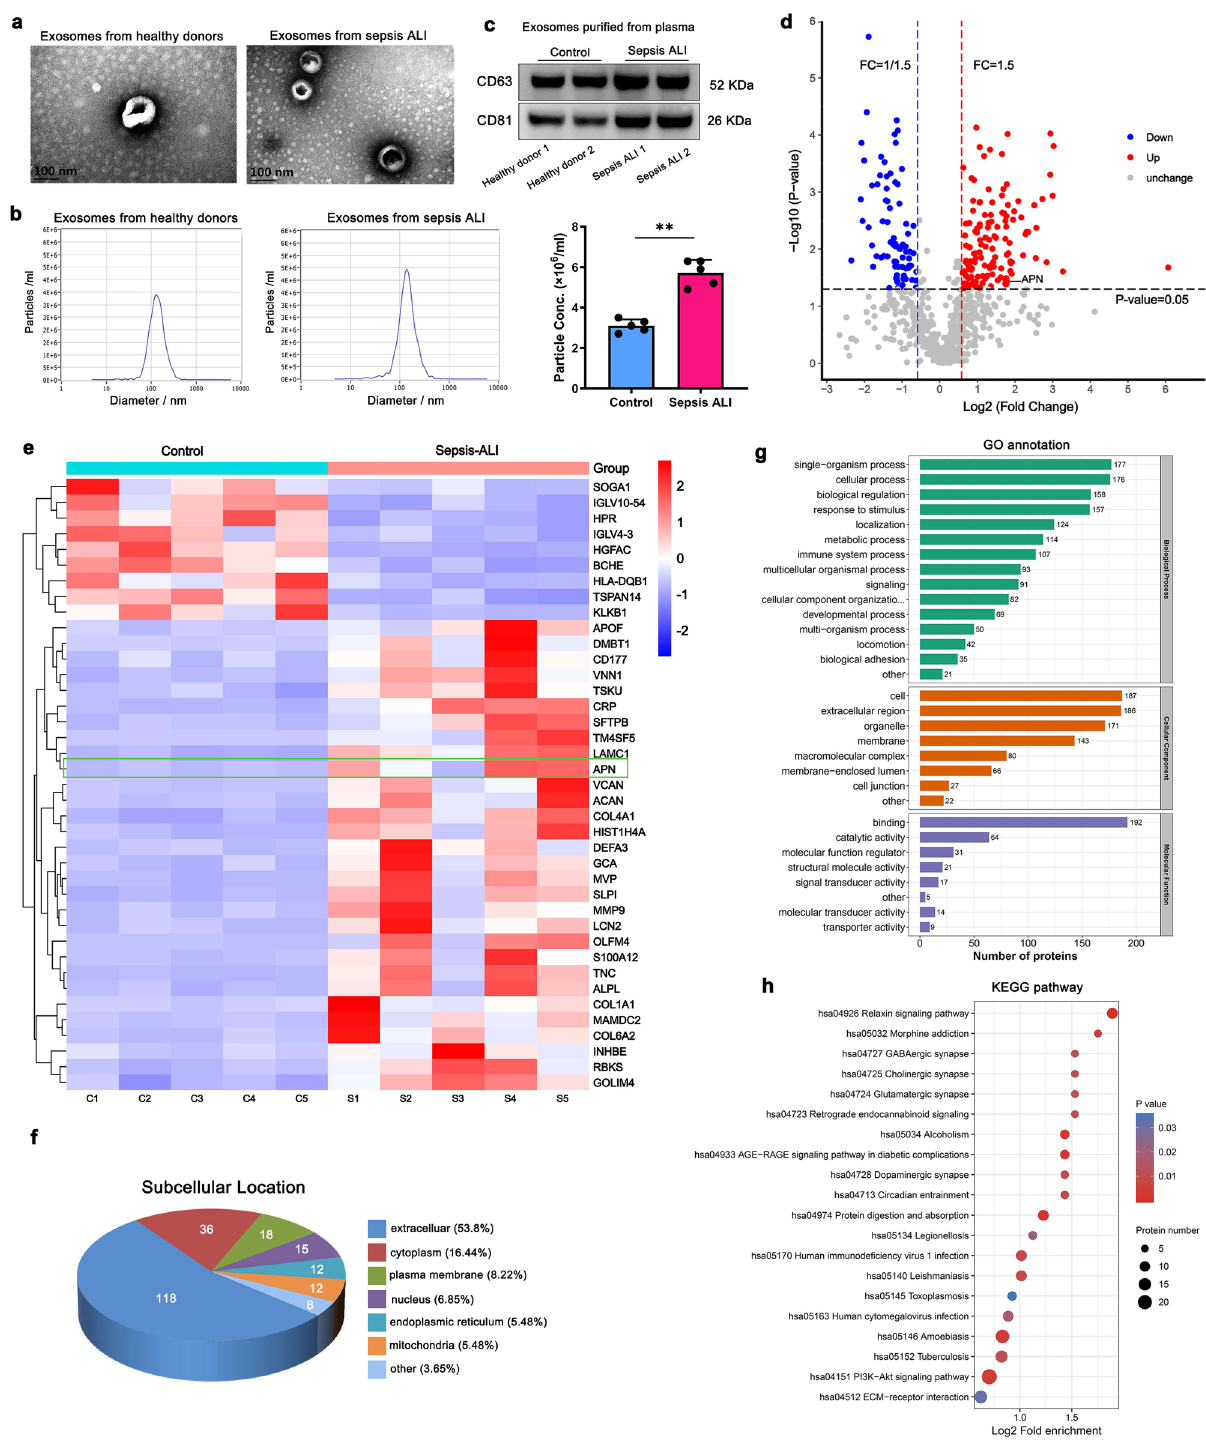
Fig. 1 Proteomics analysis of plasma exosomes from the controls and sepsis-induced ALI patients. a Scanning electron microscopy images of plasma exosomes from healthy donors and patients with ALI caused by sepsis (scale bar: 100 nm). b Concentration (particles/mL) and modal size (nm) of exosome samples according to NTA measures. Mean ± SD ( n = 5), ** P < 0.01. c Exosome markers, including CD63 and CD81, were analyzed using western blot analysis. d Volcano plot showing differentially expressed protein in plasma exosomes from the healthy donors compared to sepsis-induced ALI patients. e Heatmap display showing 39 differentially expressed proteins from each group of the independent samples. f Differentially expressed proteins ’ subcellular locations. g Gene ontology (GO) annotation was performed to characterize the biological functions of these differentially expressed proteins. h KEGG pathway enrichment analysis in cases vs. control